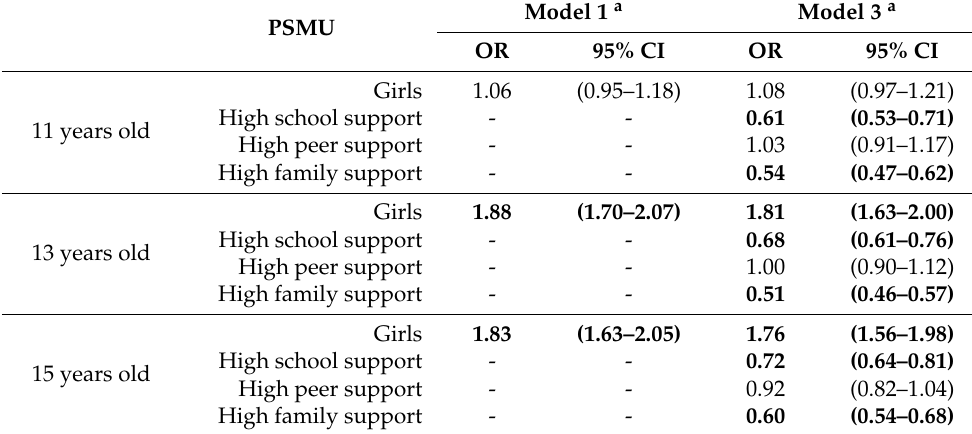
Table 4. Odds ratio (OR) and 95% confidence interval (CI) for PSMU, by age, gender and social support (school peers and family); Italian HBSC